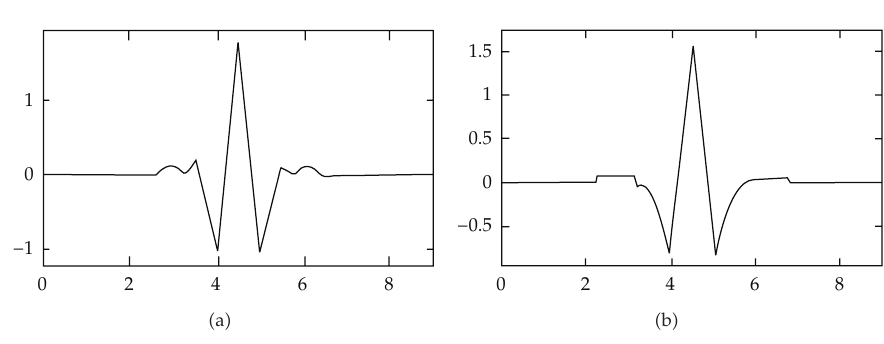
Figure 1: Biorthogonal wavelet (cid:2) db8 (cid:3) for decomposition (cid:2) a (cid:3) and reconstruction (cid:2) b (cid:3)